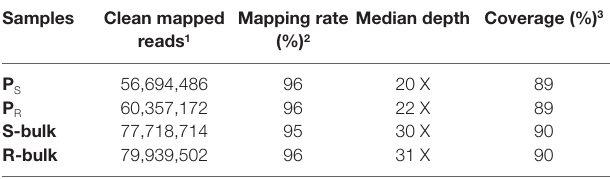
TABLe 1 | Results from the resequencing of P S , P R , S-bulk and R-bulk. Samples Clean mapped reads